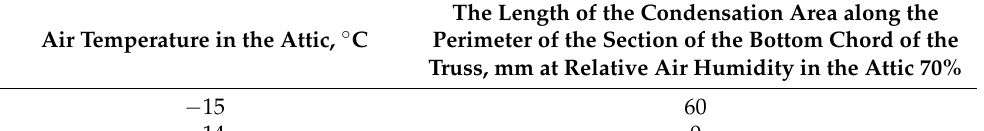
Figure 18. Calculation scheme without a gusset plate. The gaps between the angles and precast reinforced concrete elements are filled with thermal insulation (units: mm). Table 6. The length of the condensation area along the perimeter of the section of the bottom chord of the truss, depending on the temperature and relative humidity of the air in the attic (calculation scheme without a gusset plate: the gaps between the angles and precast reinforced concrete elements are filled with thermal